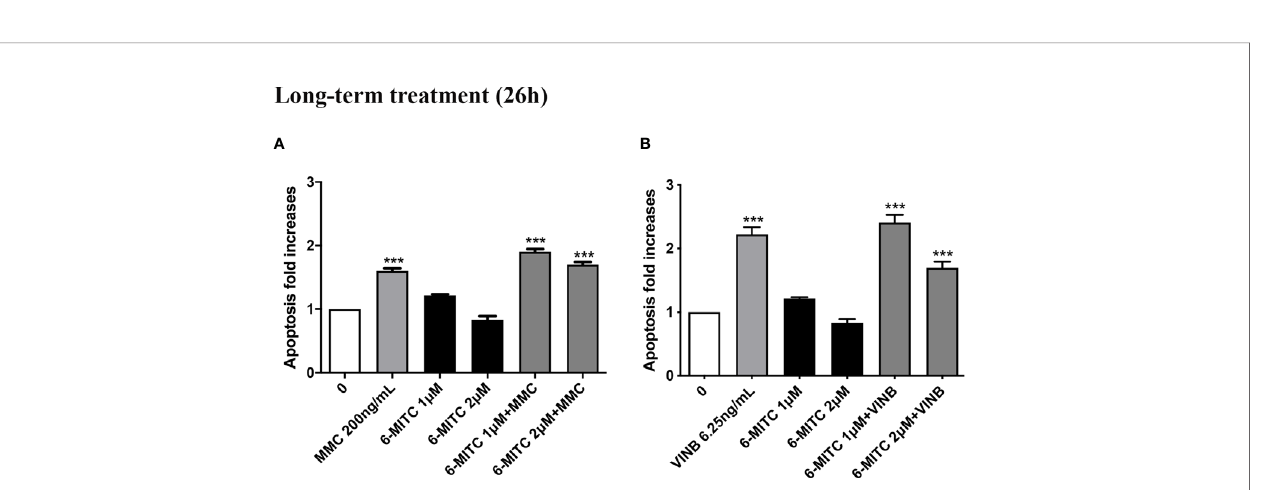
FIGURE 12 | Effect of 6-MITC on apoptosis after long term treatment. Apoptosis fold increase in TK6 cells treated with 6-MITC for 26h in presence or absence of MMC 200ng/mL (A) or VINB 6.25ng/mL (B) . Each bar represents the mean ± SEM of fi ve independent experiments. Data were analysed using repeated ANOVA followed by Dunnet post-test. ***p < 0.001 vs